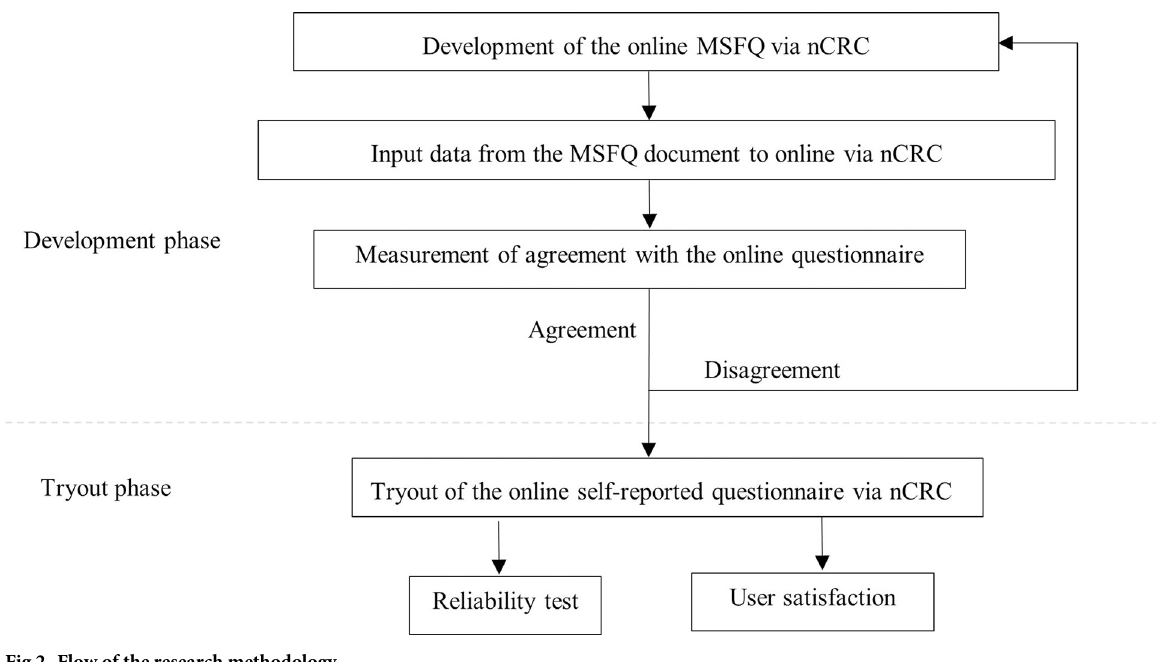
Fig 2. Flow of the research